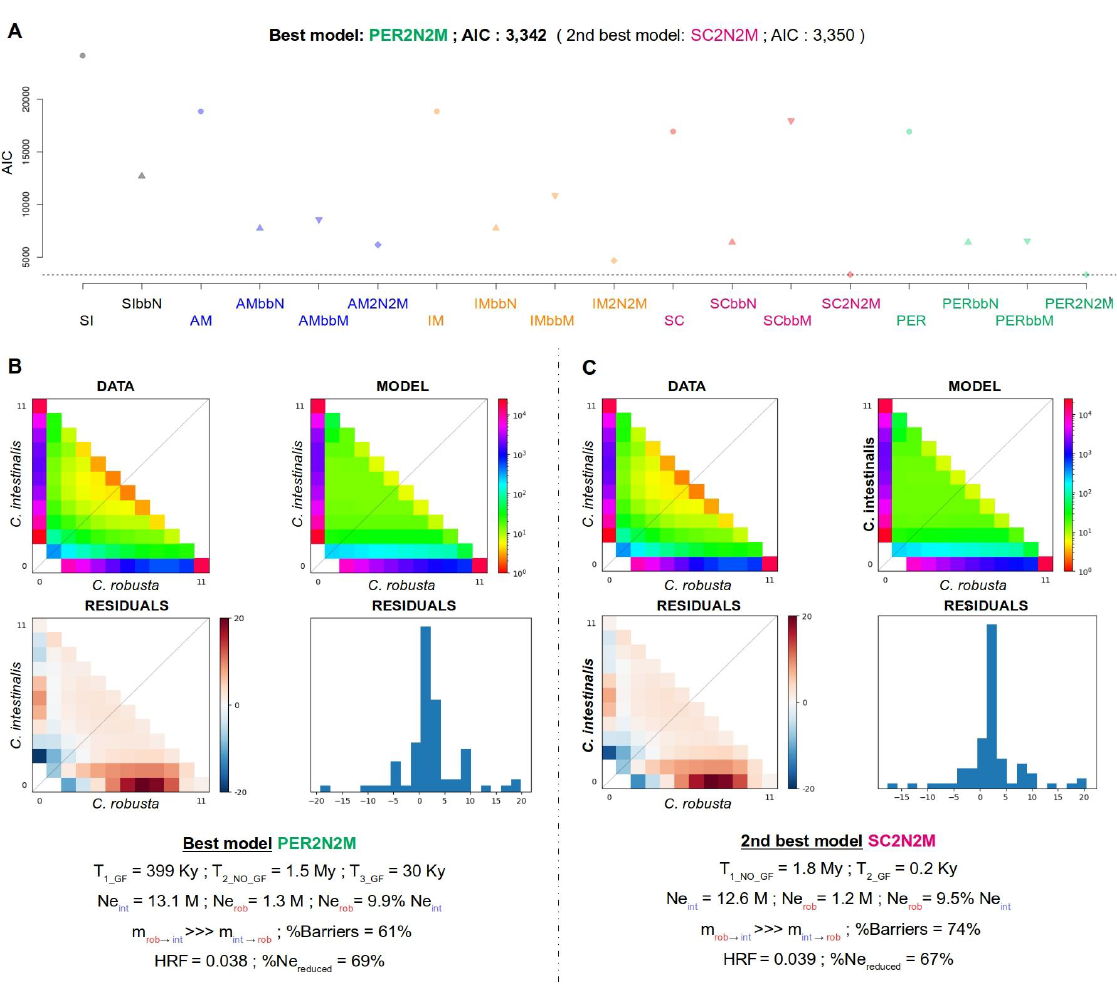
Figure 3: I nference of the divergence history between C. robusta and C. intestinalis with moments. A. AIC value of the best run for each model. B. Observed site frequency spectrum (SFS), modeled SFS and residuals of the best model. Maximum likelihood values of the parameters are provided. C. Same as in B but for the second-best model. Analyses were based on the folded SFS after LD-pruning the SNPs. Five demographic scenarios were modeled: SI = strict isolation, IM = isolation with continuous migration, SC = secondary contact, AM = ancient migration, PER = periodic connectivity. Different versions of these scenarios were tested: bbN = genomic heterogeneity of the effective population sizes, bbM = genomic heterogeneity of the effective migration rates, 2N2M = both types of heterogeneities, “” = no heterogeneities. Five replicates were run for each model. Parameters are as follows: T = times in years, assuming two generations per year in European waters (the “GF” label refers to gene flow), Ne = effective population sizes in numbers of individuals, m = migration rates (direction given by the arrow), %Barriers = proportion of the genome with null migration, %Ne reduced = fraction of the genome experiencing reduced Ne, HRF = factor by which Ne is reduced. Full details are provided in Table S3 . Dataset #5 “all SNPs without missing data” was used, excluding chromosome 5. creating a signal of long-range LD around it. This signal can be captured by the extended haplotype homozygosity (EHH), which measures the decay of identity-by-descent between haplotypes as a function of the distance from a focal SNP. Taking as targets the SNPs with the highest C. robusta frequency to the left and right of the “missing data region”, we observed a slower EHH decay on the C. robusta haplotypes compared to other haplotypes in the sympatric C. intestinalis populations, but not in the C. roulei population ( Figure 4E ). To test for significance, the absolute normalized integrated haplotype score (iHS) was then calculated in 50-Kb windows along chromosome 5, and we estimated the proportion of SNPs in each window associated with outlying values of